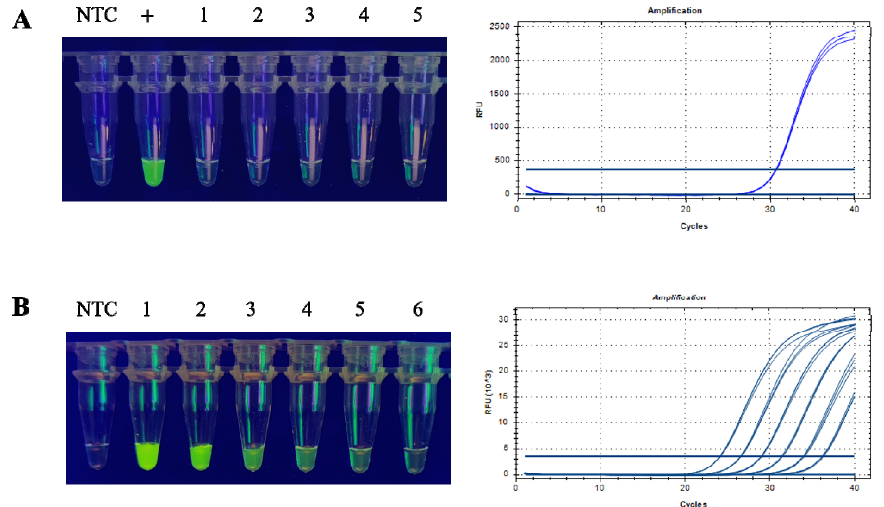
Figure 5. Specificity and sensitivity analyses. ( A ) Specificity evaluation of the CRISPR/Cas12a assay for T-nos detection. The same samples were measured by qPCR. +, positive samples; Lanes 1 − 5, non-GM cotton, non-GM soybean, non-GM rice, non-GM canola, non-GM corn. ( B ) Sensitivity evaluation of the CRISPR/Cas12a assay for T-nos detection. The same samples were measured by qPCR. Lanes 1 − 6, 1.88 × 10 4 , 3.75 × 10 3 , 7.5 × 10 2 , 1.5 × 10 2 , 30, and 6 copies/ μ L GM soybean. NTC, no template control.